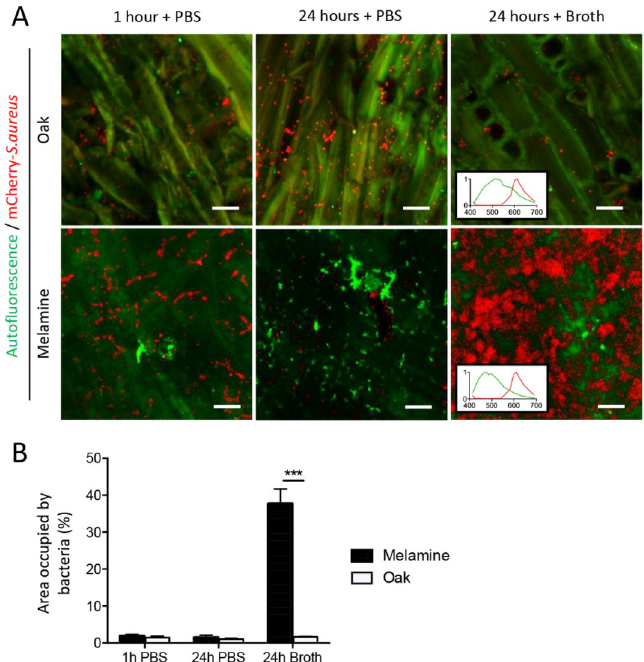
Figure 5. mCherry— S. aureus biodistribution on the surface of an oak disc and melamine piece. (A) Confocal imaging of mCherry— S. aureus (red) on tangential oak disc and melamine piece (green; respectively, upper and lower panel) 1 h, 24 h in presence of PBS and 24 h in presence of broth. Graphics representing autofluorescence of oak and melamine (green) in presence of mCherry (red) are both presented in 24 h both broth pictures. Scale bar = 20 µm. (B) Quantification of the surface occupied by mCherry— S. aureus spots related to total area of oak and melamine (Two-way ANOVA, Sidak post-hoc test. Error bars represent SEM of the mean. ***p <